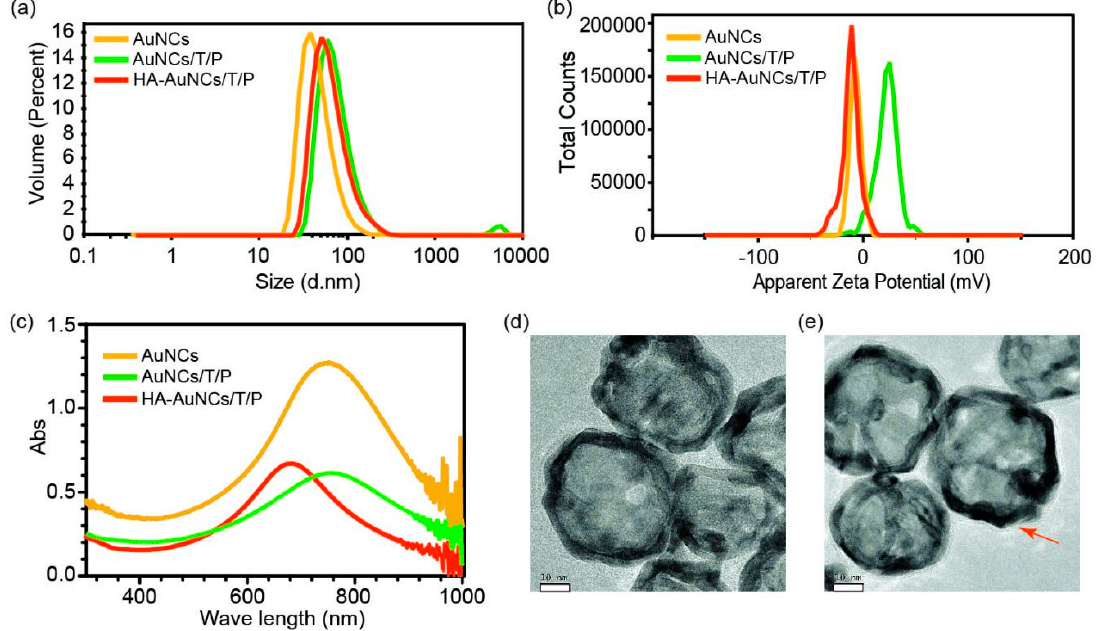
Figure 1. The characterization of AuNCs, AuNCs/T/P, and HA-AuNCs/T/P: ( a ) Size distribution and ( b ) zeta potential of AuNCs, AuNCs/T/P, and HA-AuNCs/T/P; ( c ) UV-Vis absorption spectra of AuNCs, AuNCs/T/P, and HA-AuNCs/T/P; and TEM micrograph of ( d ) AuNCs and ( e ) HA-AuNCs/T/P (scale bar: 10 nm).